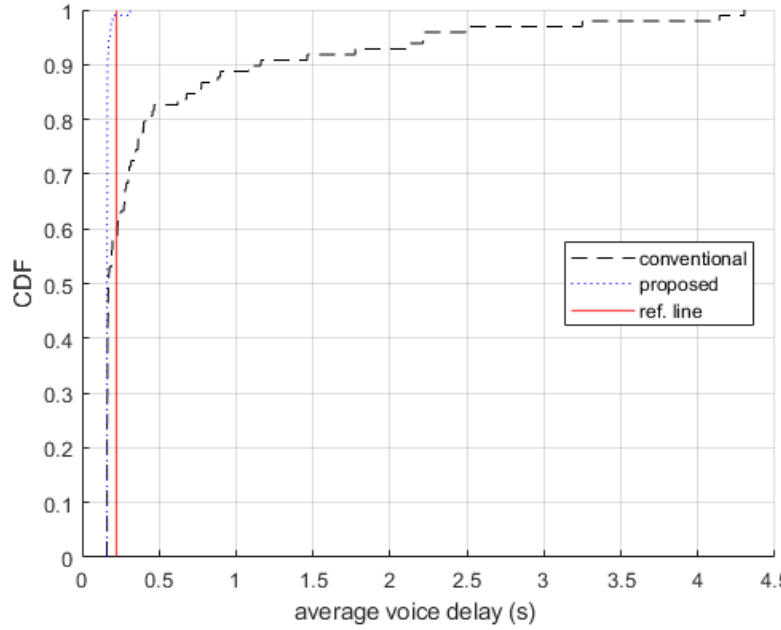
Figure 13. Average delay CDF for voice traffic of 100